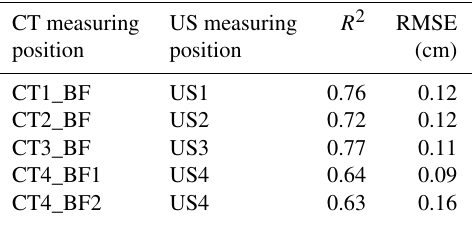
Table 3. Relationship between back-fat thickness measured on a single CT image and back-fat thickness measured by ultrasound (US) ( n = 33, p < 0 .